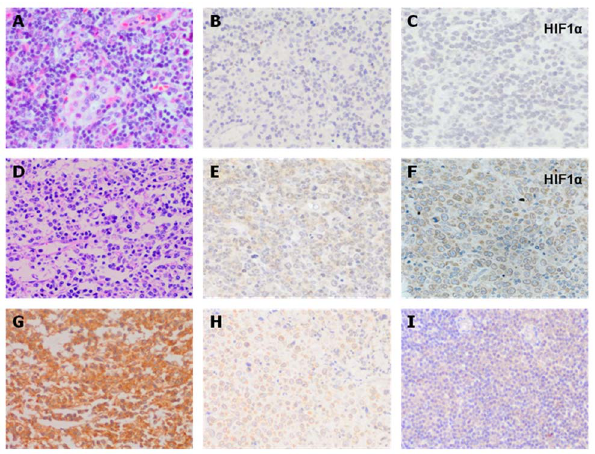
Figure 3. Expression patterns of LDH-5 and HIF1 a shown by immunohisto-chemical staining in patient tissues. (A–C) Patients with benign lymphadenectasis, (A) representative examples of HE staining, (B) LDH-5 expression (negative), and (C) HIF1 a expression (weak positive); (D–I) Patients with NHL, (D) HE staining; (E) LDH-5 expression in DLBCL (positive), (F) HIF1 a expression in DLBCL (positive), and (G) strongly positive expression of LDH-5 in follicular lymphoma; (H) strongly positive expression of LDH-5 in NK/T cell lymphoma; (I) positive expression of LDH-5 in small cell lymphoma. Original magnification, 6 400.